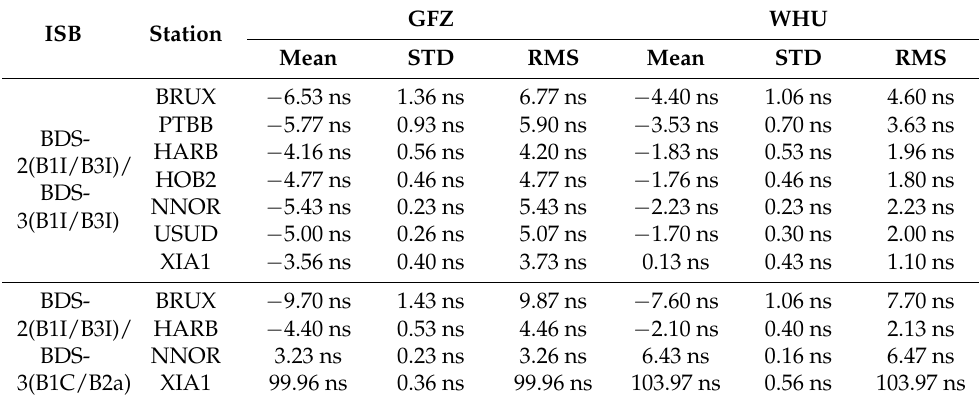
Figure 6. The ISB between BDS-2 (B1I/B3I) and BDS-3 (B1C/B2a) for GFZ and WHU from DOY 101 to 130, 2020. Table 4. Statistics of ISB between BDS-2 and BDS-3 from DOY 101 to